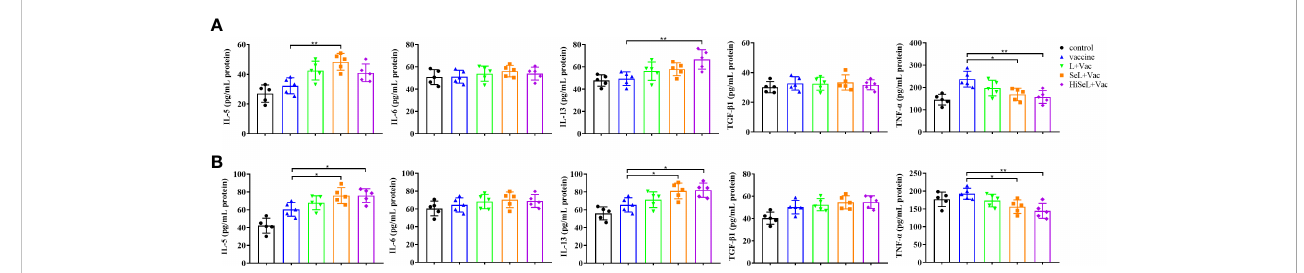
FIGURE 3 Effect of SeL and HiSeL on the secretion of cytokines related to SIgA induced by the immunization of mice. Sera samples of mice were gathered on days 1 and 28 after immunization to detect cytokines related to SIgA. (A) Results of cytokine in sera on the fi rst day after immunization. (B) Results of cytokine in sera on the 28th day after immunization. Each experimental group consisted of fi ve mice per group. Data were presented as means ± SD (*P < 0.05, and **P < 0.01). The statistical analysis was performed using one-way ANOVA.